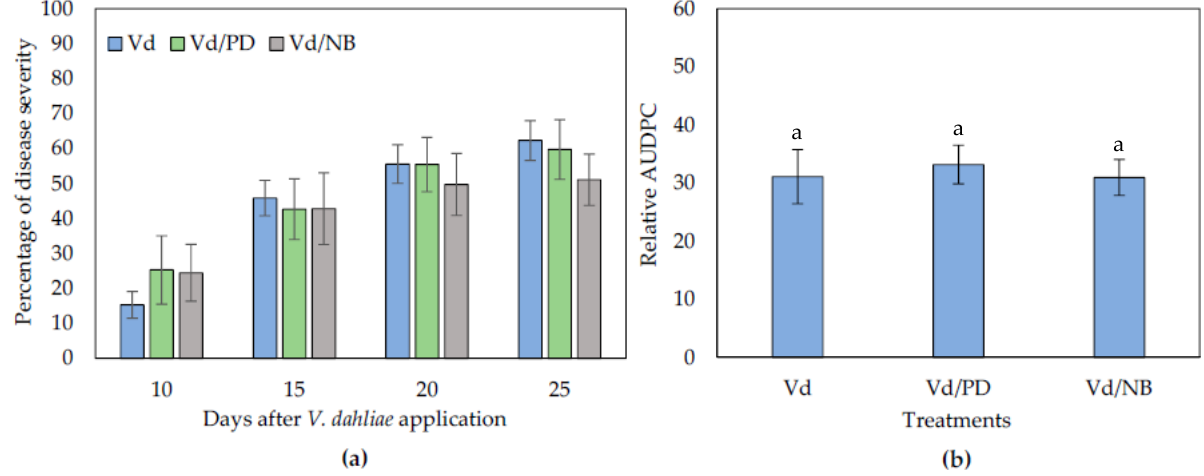
Figure 4. Verticillium disease severity ( a ) and relative AUDPC ( b ) caused by artificial inoculation of V. dahliae (Vd), on eggplants treated with PD and NB, in a split root system. Each treatment consisted of 10 plants and the experiment was repeated three times. Columns represent means of the three replications ( n = 30 plants) and the vertical bars indicate standard errors. For disease severity ( a ), columns with asterisks (*) are significantly different ( p < 0.01) from control (Vd) according to t -test, for each time point; for relative AUDPC ( b ), columns with different letters are significantly different ( p < 0.05) from each other according to LSD test.